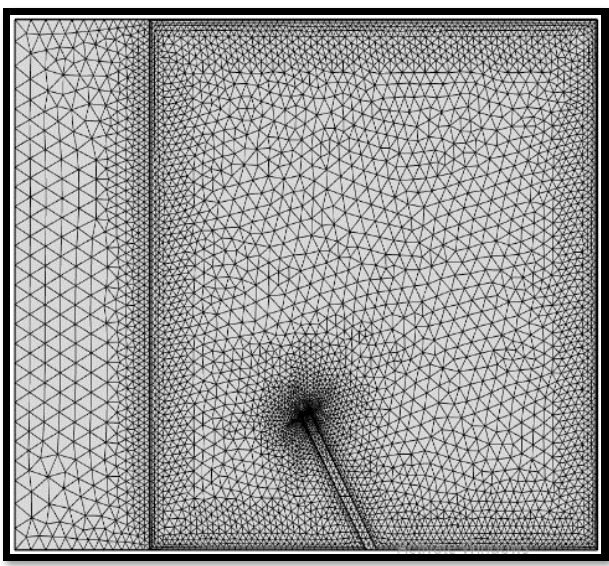
Figure 2. The triangle mesh distribution of the